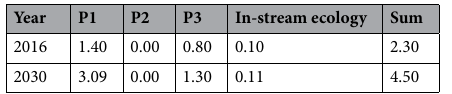
Table 8. The annual average water shortage (billion m 3 ).